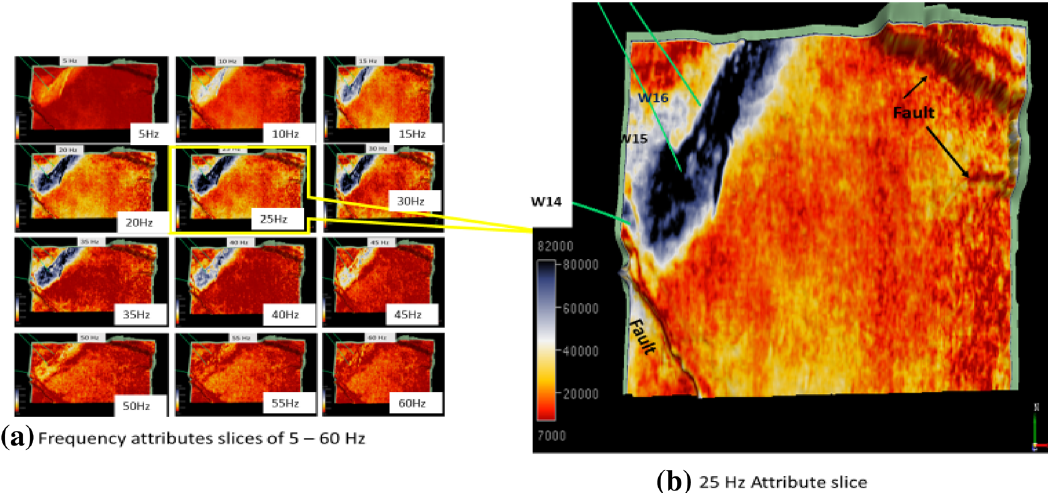
Fig. 11 Frequency slices showing different shades of anomalous dark zone